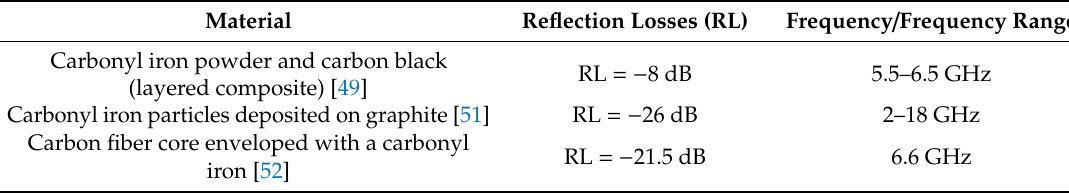
Table 5. Reflection losses of iron powder-based